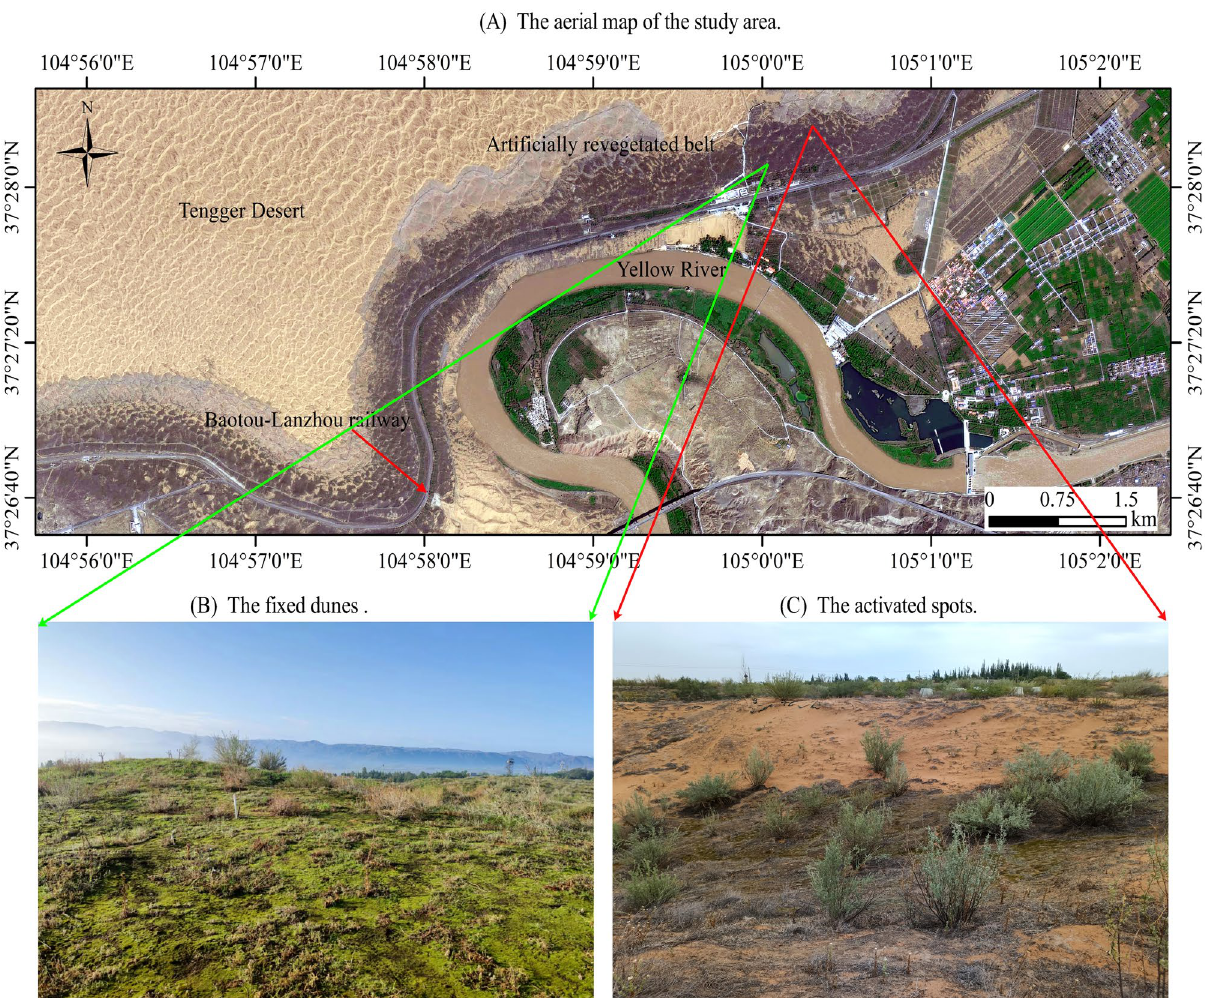
Figure 1. Schematic description of the study area. ( A ) The aerial map of the study area; ( B ) the fixed duns; ( C ) the activated spots in the artificially re-vegetated belt. (Using ArcGIS v. 10.8 software; Powered by ESRI “Environmental Systems Research Institute”, www. esri.